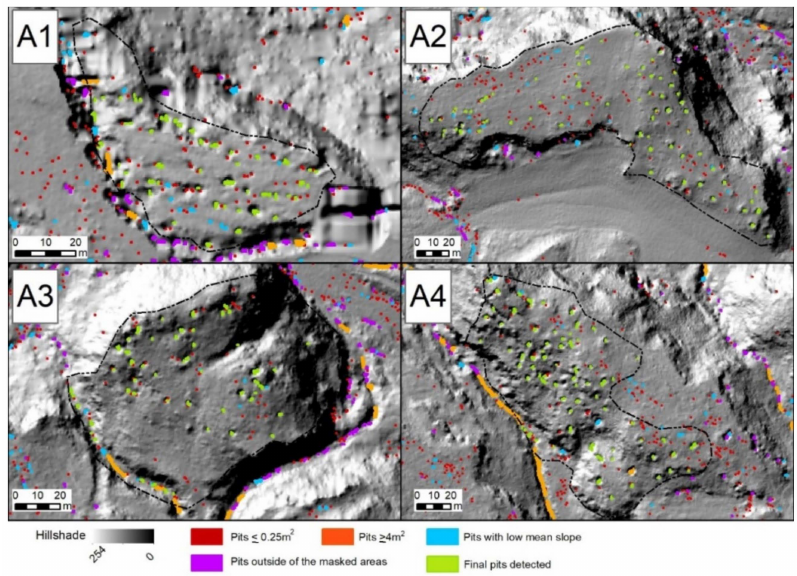
Figure 8. Geomorphon results on the four areas of interest. The VT map herein showed is HS.